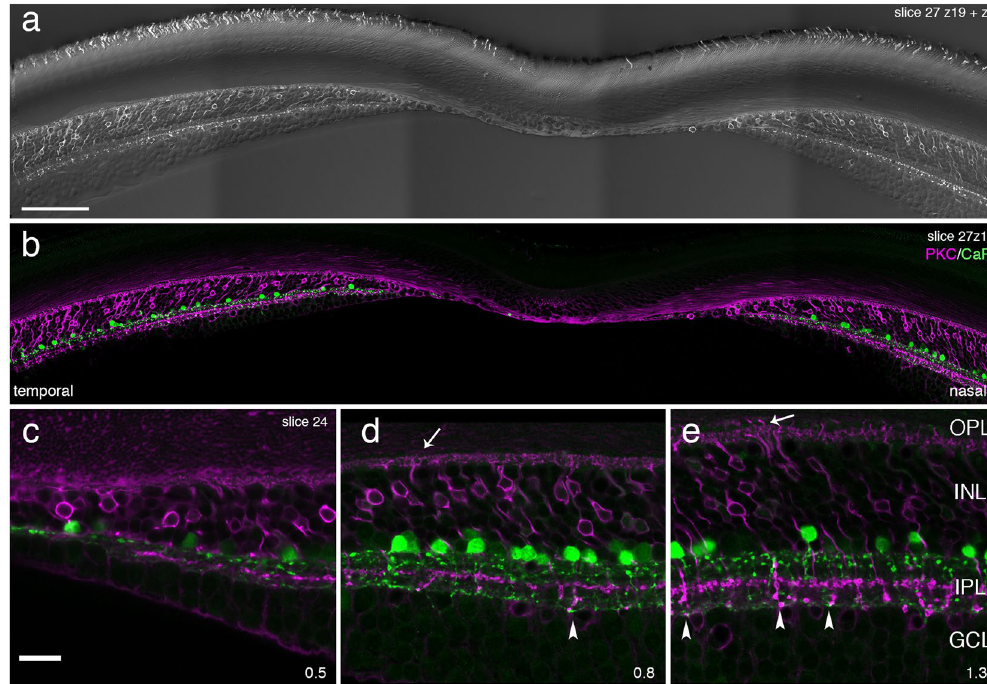
Figure 2. Rod pathway neurones in macaque fovea. Confocal images of vibratome sections through the fovea that were processed with antibodies against rhodopsin to reveal rods, antibodies against protein kinase C (PKC) to reveal rod bipolar cells and antibodies against calretinin (CaR). ( a ) Photomontage of two confocal planes (z5) to show rod labelling and (z19) to show rod bipolar labelling. ( b ) Same section as in a (z19) showing PKC labelled bipolar cells (magenta) and calretinin labelled amacrine cells (green). ( c–e ) The nasal area of a different section from the same preparation is shown. The arrowheads point to rod bipolar axon terminals, the arrows point to rod bipolar dendrites. OPL, outer plexiform layer; INL, inner nuclear layer; IPL, inner plexiform layer; GCL, ganglion cell layer. Scale bar shown in a = 100 µ m (valid for a,b ); scale bar shown in c = 20 µ m (valid for c–e